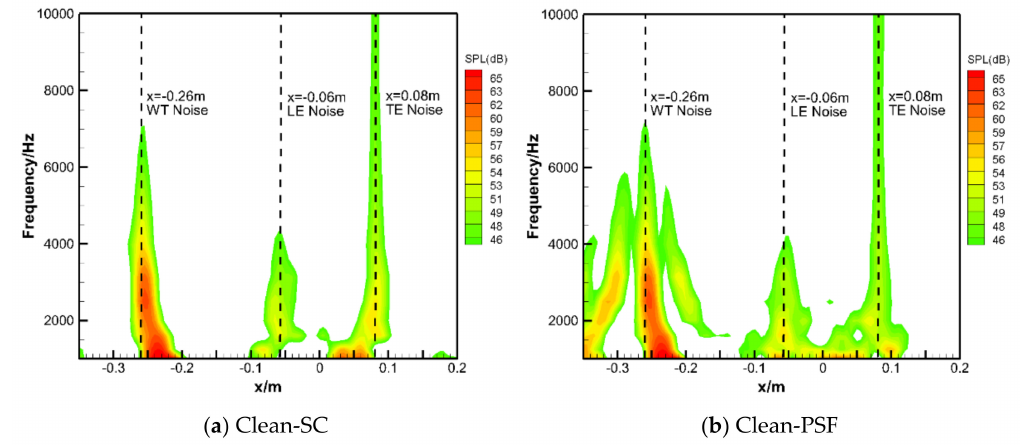
Figure 9. Noise maps of the blade test for U = 40 m/s.